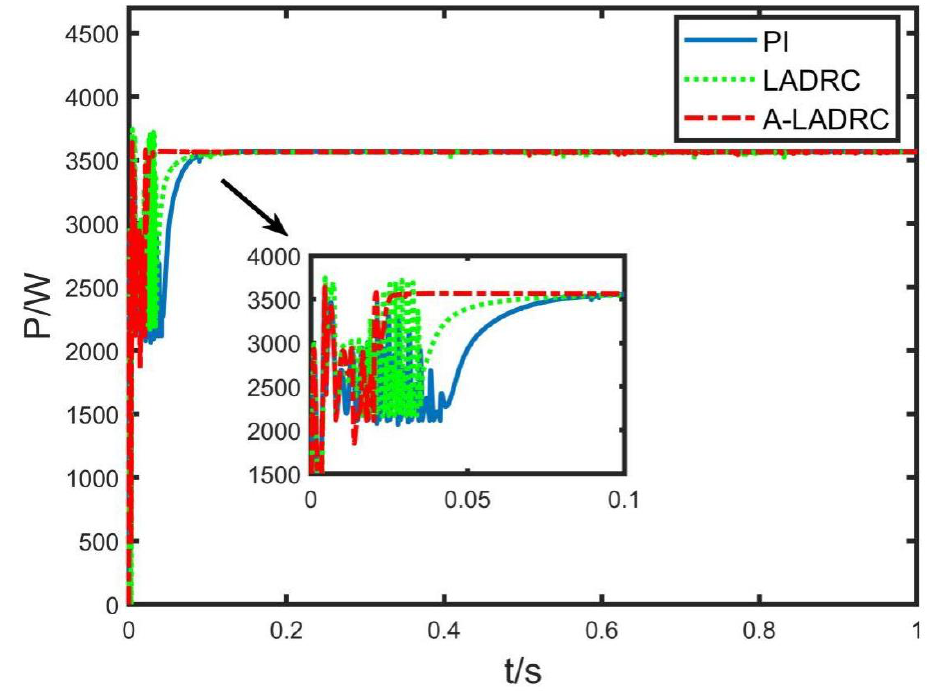
Figure 11. Output power of PV array under local shadows.